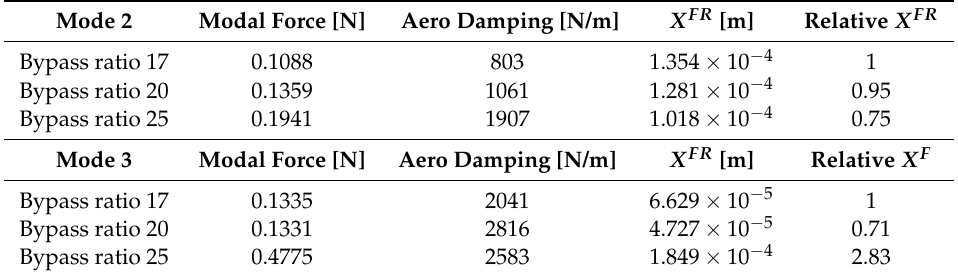
Table 2. Comparison of forced response amplitude with modal force and aero